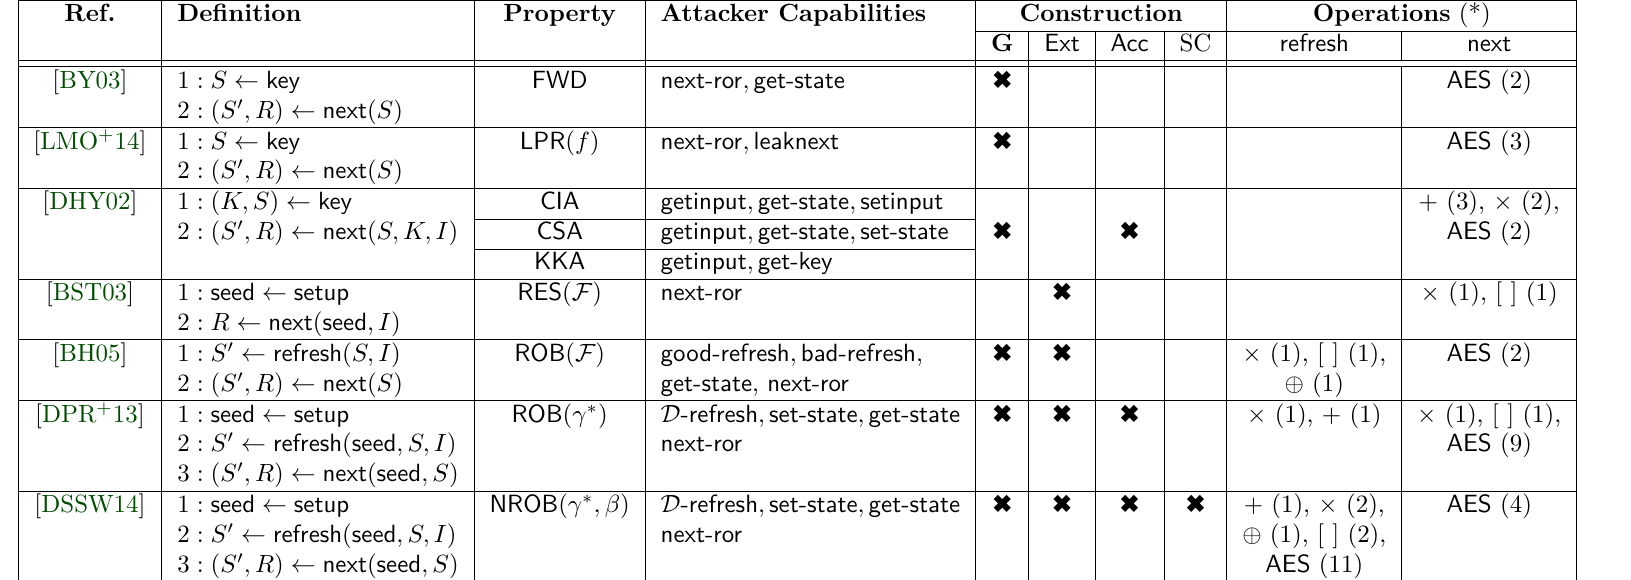
Table 1: Security Properties of Pseudo-Random Number